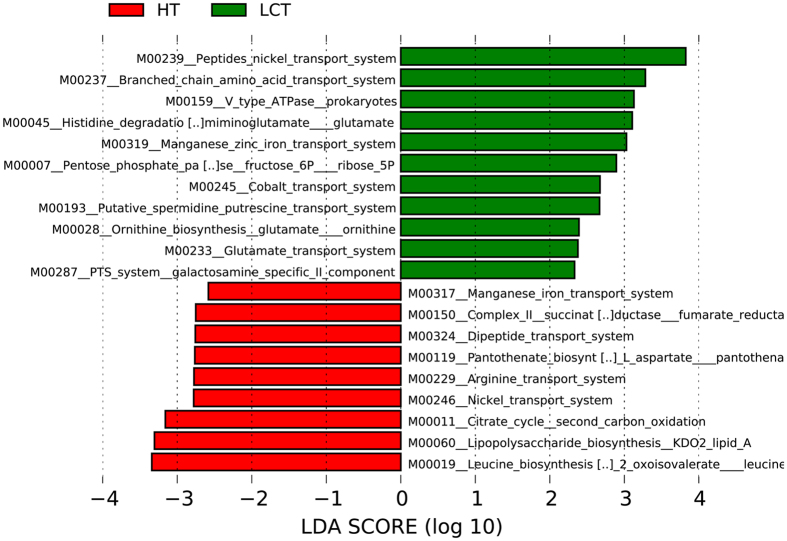
LDA scores predict gene function associated with tongue coat microbiomes in LC patients using PICRUSt.PICRUSt: Phylogenetic Investigation of Communities by Reconstruction of Unobserved States. LCT, liver cancer patients tongue coat; HT, healthy subjects tongue coat.